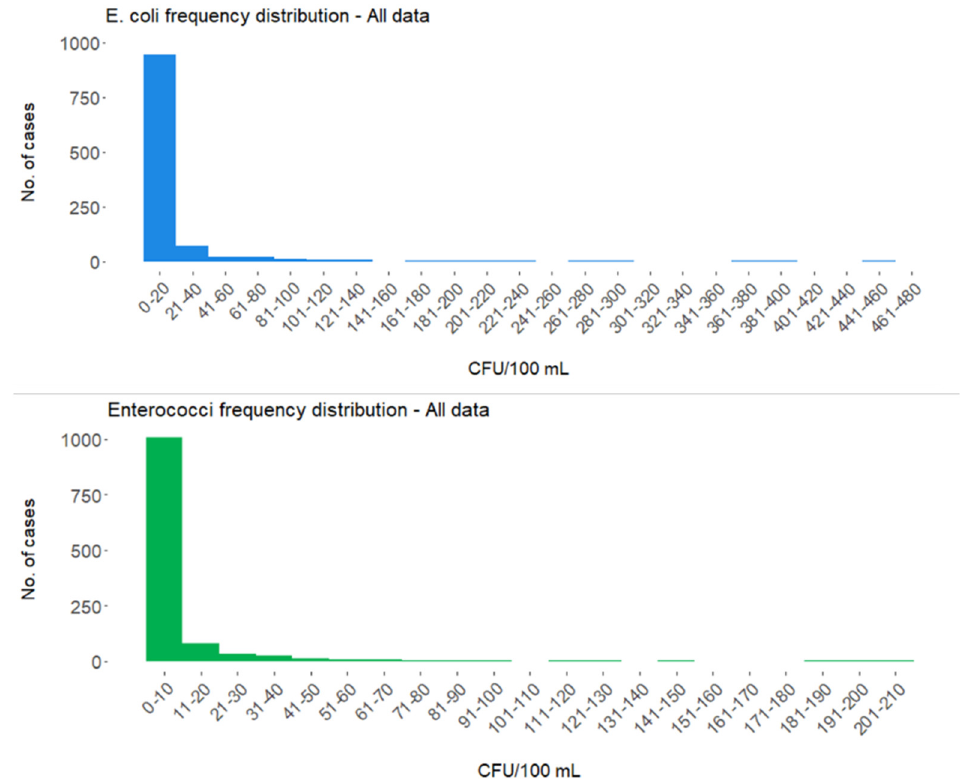
Figure 3. Frequency distribution of the abundances of Escherichia coli (blue) and Enterococci (green), considering all data collected at all sites.